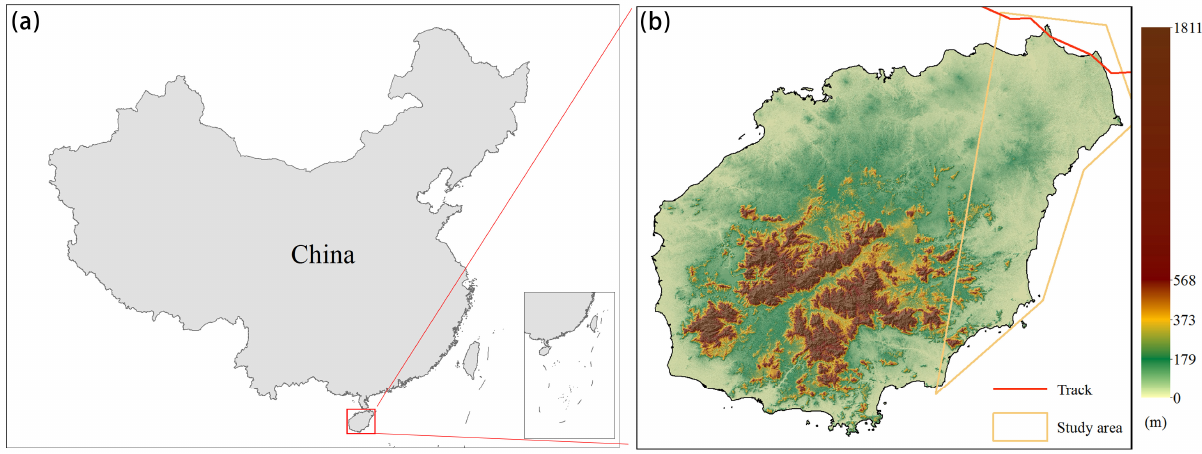
Figure 1 . Location (a) and elevation (b) of Hainan Island